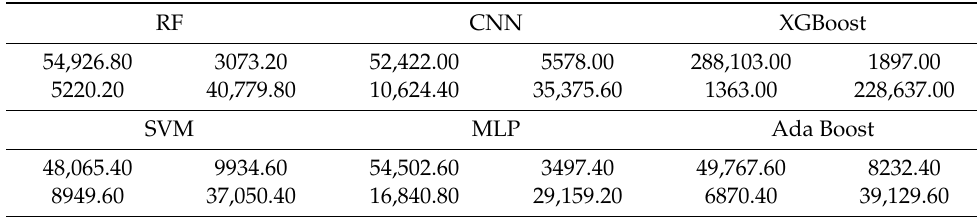
Table A4. Two Classes, Maximum